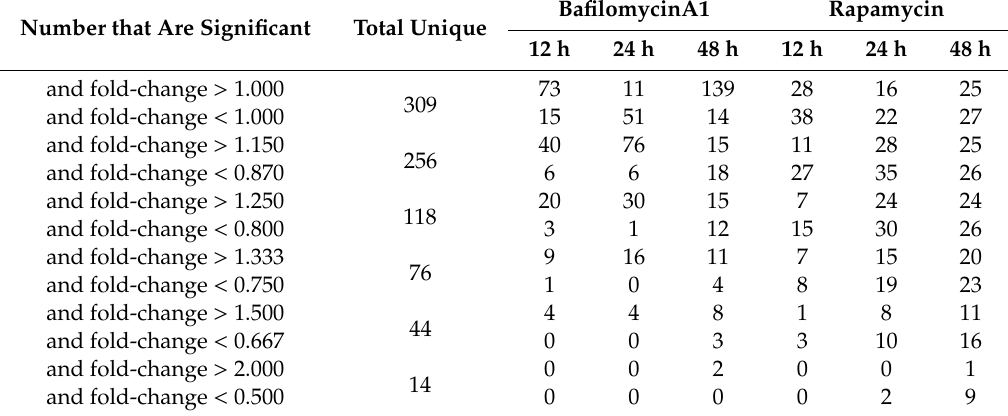
Table 1. Numbers of significantly dysregulated proteins at indicated cut-o ff s.